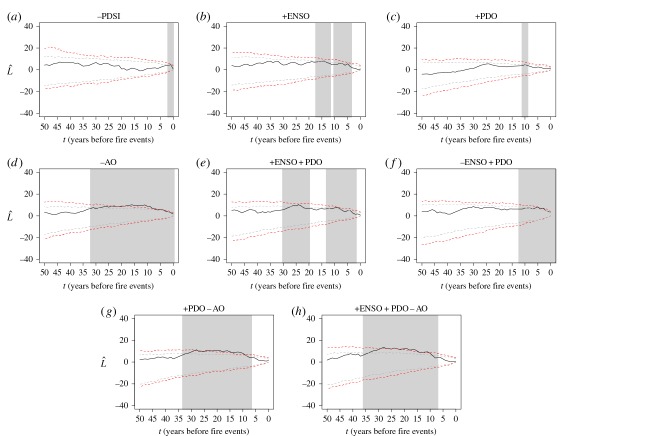
Bivariate event analysis (BEA) of the temporal association between fire years and extreme climate events. Abbreviations are the ENSO, the PDO, the PDSI and the AO, and the (+) and (−) signs indicate phase combinations. Black lines above the dotted red (99% confidence envelopes) and the dotted grey (95% confidence envelopes) lines indicate synchrony between the two events (events occurred more often than expected, t years prior to fire events). Confidence envelopes are based on 1000 Monte Carlo simulations and years of significant synchrony are shaded in grey. Further results are provided in the electronic supplementary material, table S5, figures S2 and S3.